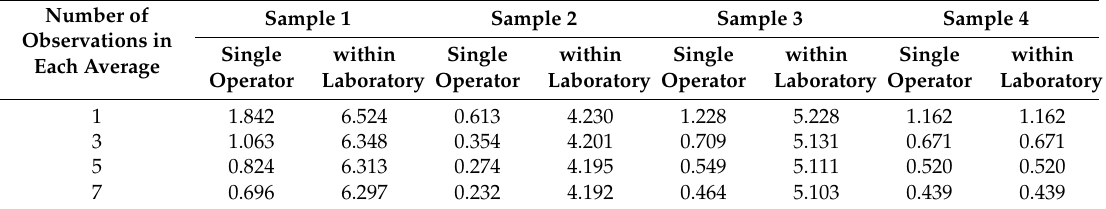
Table 9. Critical differences of maximum heat flux vale for thermal transfer properties.